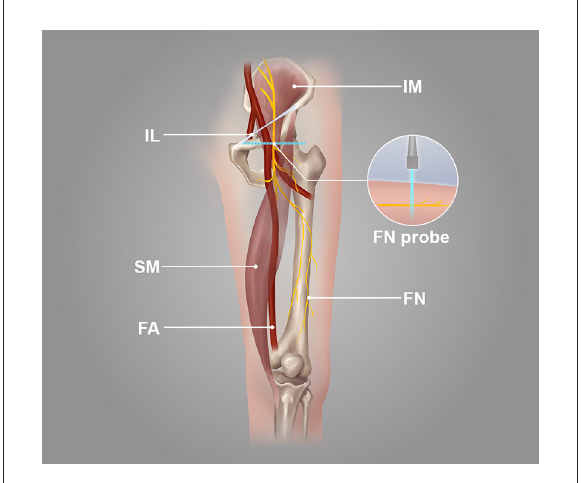
FIGURE1 The position of the probe in the transverse section of the femoral nerve.